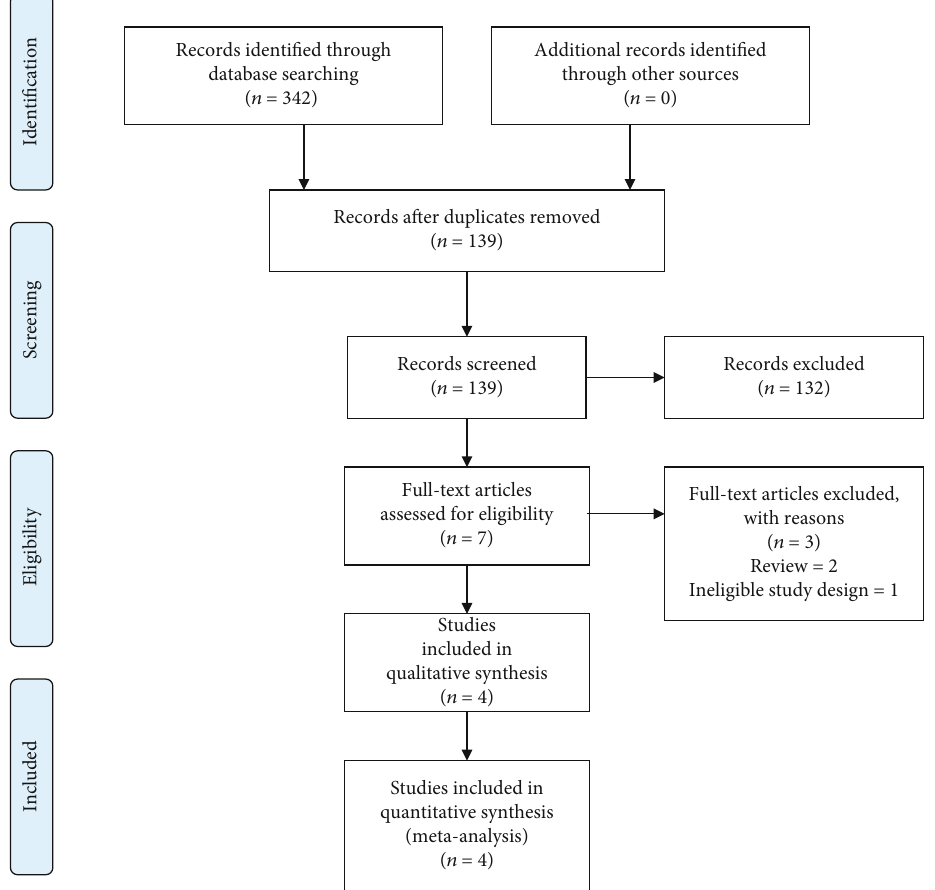
Figure 1: Flow diagram of the study selection